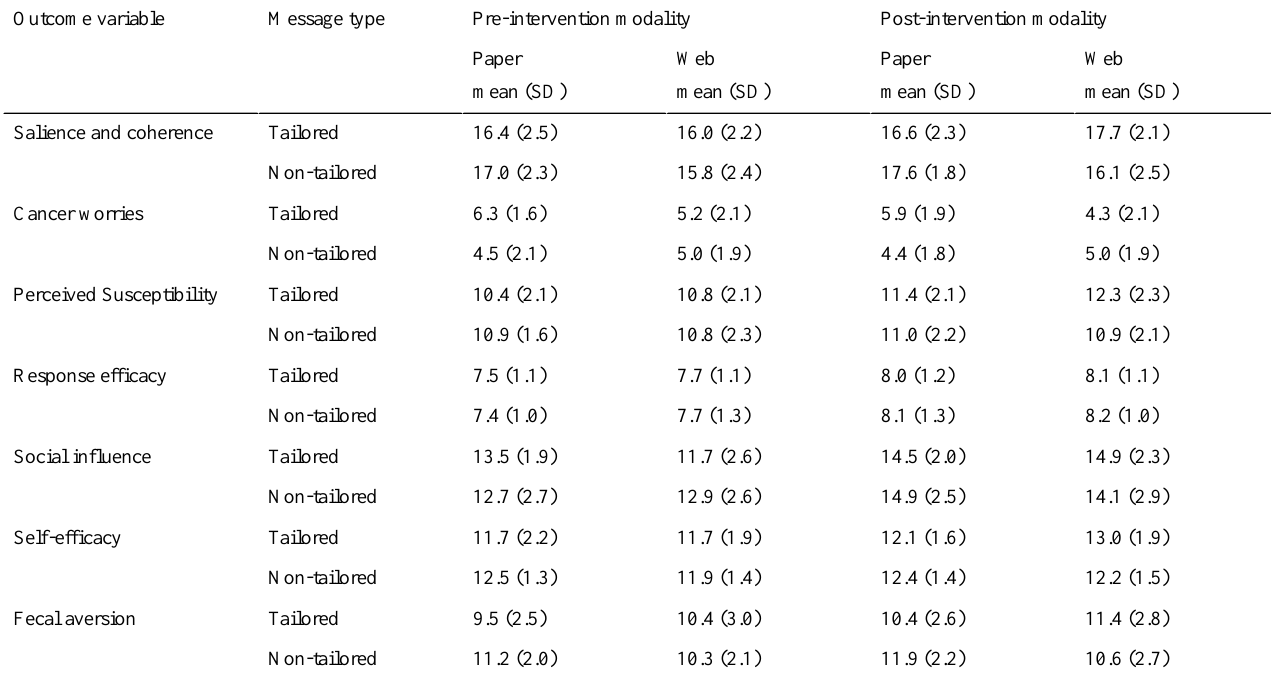
Table 6. Means and standard deviations on all PHM, fecal aversion, and self-efficacy outcome variables according to condition.